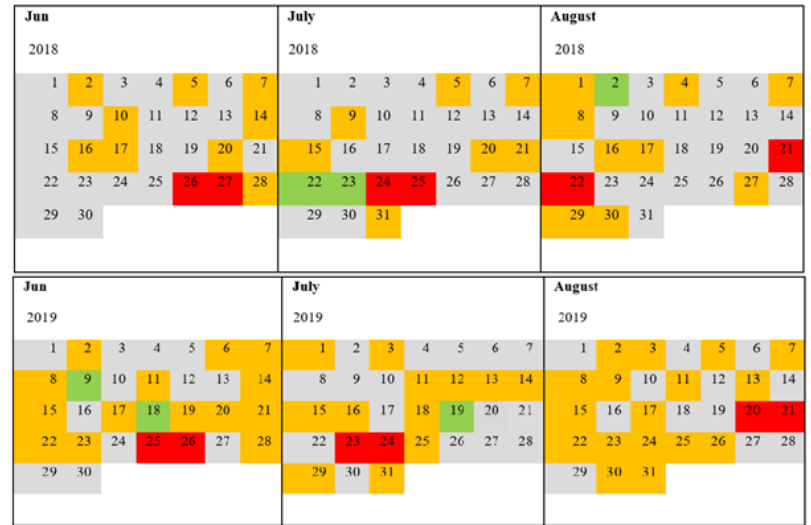
Figure 3. Eligibility for sea breeze research satellite images/days 2018–2019 June-August: green—the breeze front is visible from satellite; yellow—a clear influence of the sea on the cloud formation processes is visible, but the breeze front cannot be precisely identified because the meteorological conditions are changing; gray—the breeze front is not visible; red—the satellite did not work or was on maintenance.